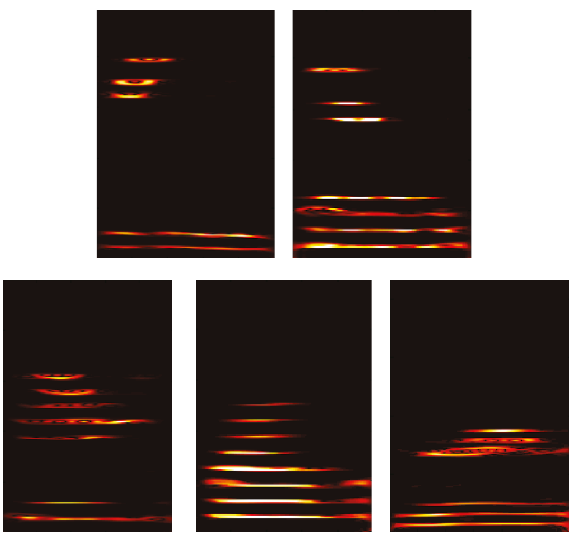
Figure 6: Illustrations of components selections provided by the proposed